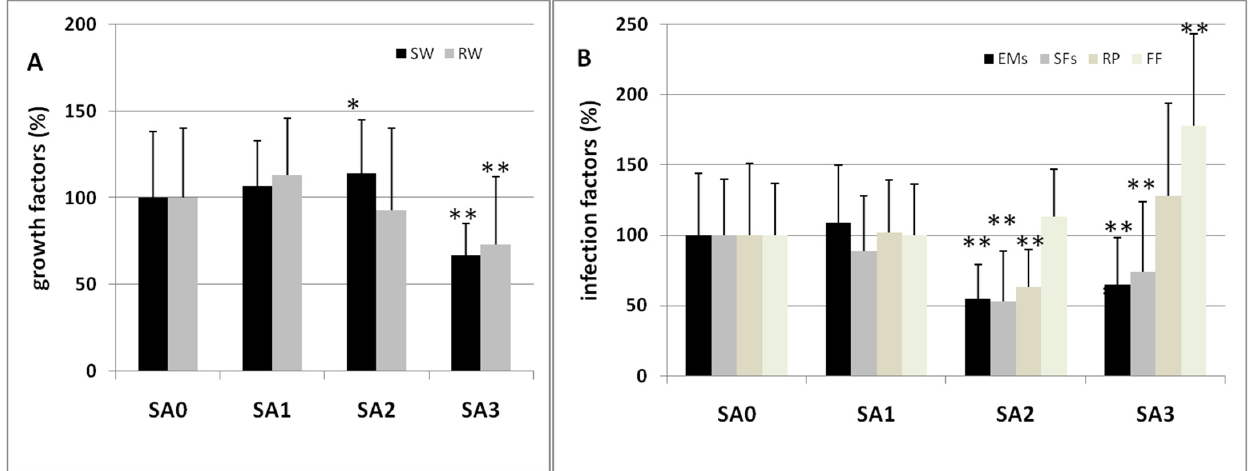
Figure 5. Effects of soil-drenched SA on plant growth ( A ) and nematode infection ( B ) in tomato plants 40 days after M. incognita inoculation. Growth factors were shoot (SW) and root (RW) weights. Infection was evaluated by the numbers of egg masses (EMs) per root system, the numbers of sedentary forms (SFs) per root system, reproduction potential (RP), and female fecundity (FF). Values for SA-treated plants are expressed in percentages with respect to untreated plants (set at 100%—SA0). Values ± standard deviations of controls were statistically differentiated from those of treatments by a paired t -test ( * p < 0.05; ** p < 0.01). Ranges of doses were expressed as mg SA g − 1 plant